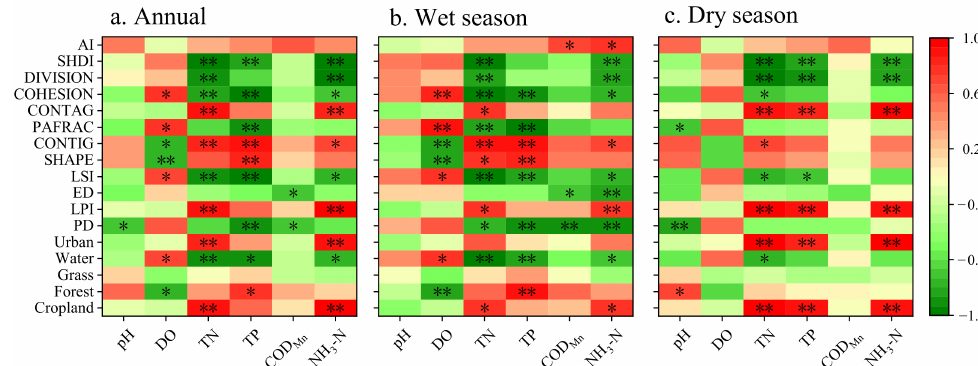
Figure 6. Relationship between land use, landscape pattern, and water quality in the Baoan Lake basin throughout the year ( a ), during the wet season ( b ), and the dry season ( c ). PD, LPI, ED, LSI, SHAPE, CONTIG, PAFRAC, CONTAG, COHESION, DIVISION, SHDI, and AI mean patch density, largest patch index, edge density, landscape shape index, shape index, contiguity index, perimeter- area fractal dimension, contagion, patch cohesion index, landscape division index, Shannon’s di- versity index, and aggregation index, respectively. In this figure, a darker red indicates a higher degree of positive correlation, and a darker green indicates a higher degree of negative